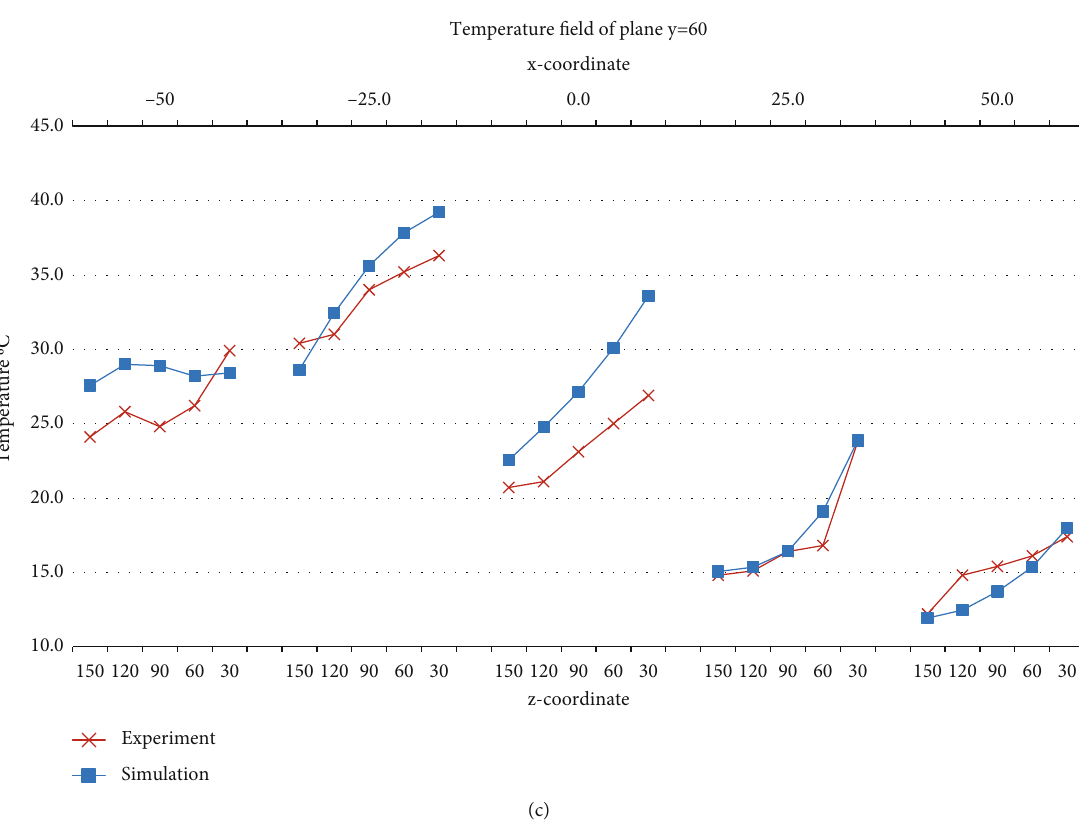
Figure 9: The plane temperature fi eld when Y is set to di ff erent values. (a) The plane temperature fi eld when Y = 0 . (b) The temperature fi eld when Y = 30 . (c) The plane temperature fi eld when Y = 60